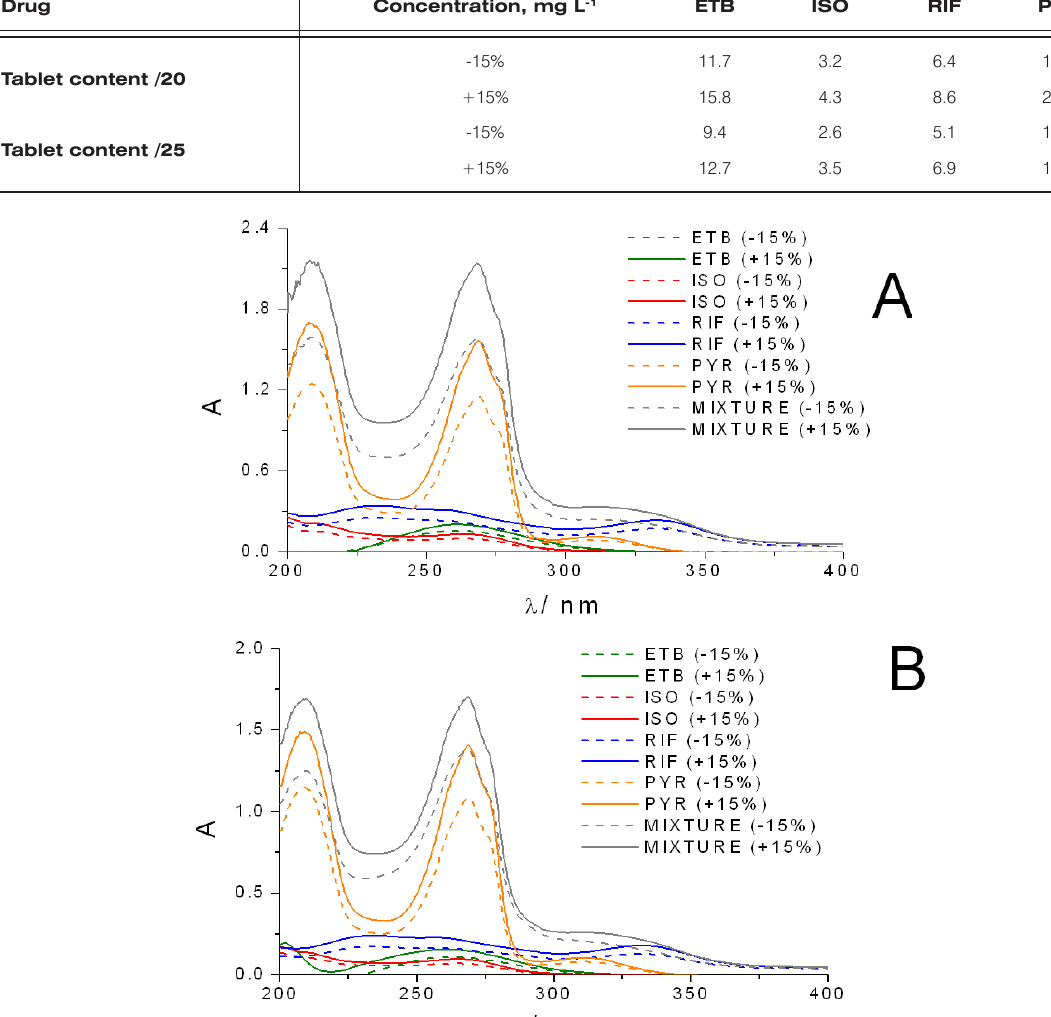
Figure 2. UV spectra of the experiments obtained for the drugs content ratio in tablet by 20 (A) and 25 (B).